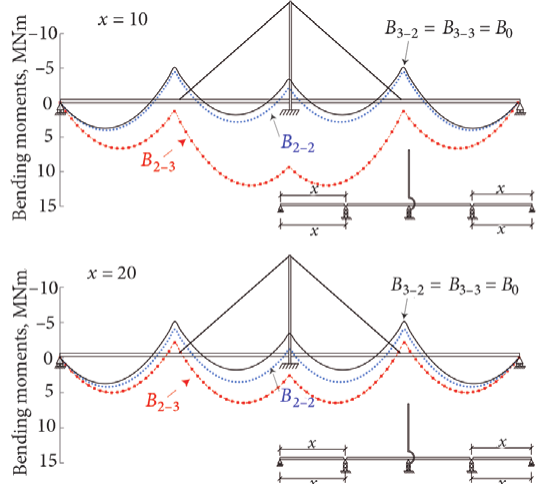
Fig. 3. Bending moments in the deck of structures B 2–2 , B 2–3, B 3–2, B 3–3 and B 0 or different location of the temporary supports and construction joints ( x ): a – x = 10 m; b – x = 20 m